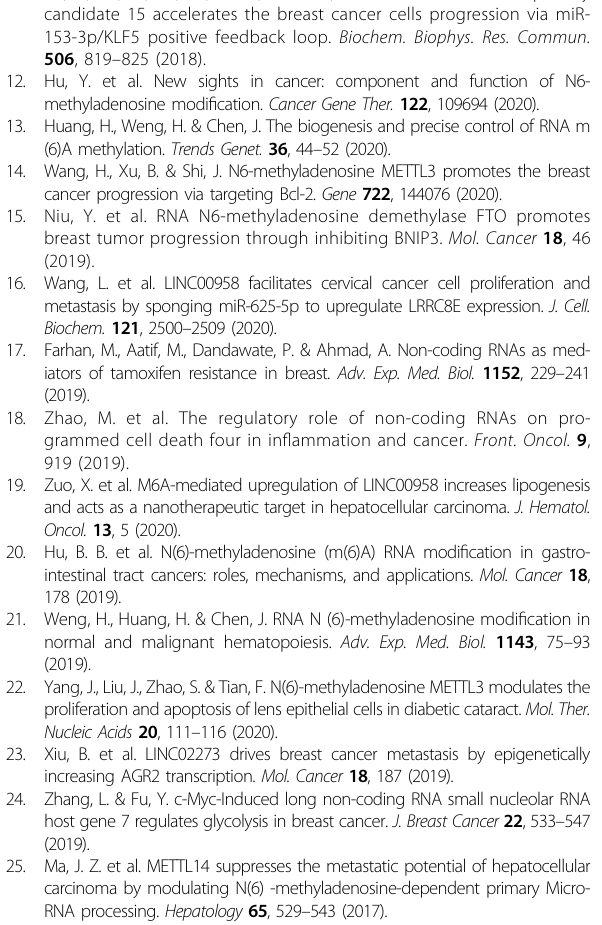
Supplementary information The online version of this article (https://doi. org/10.1038/s41420-020-00382-z) contains supplementary material, which is available to authorized